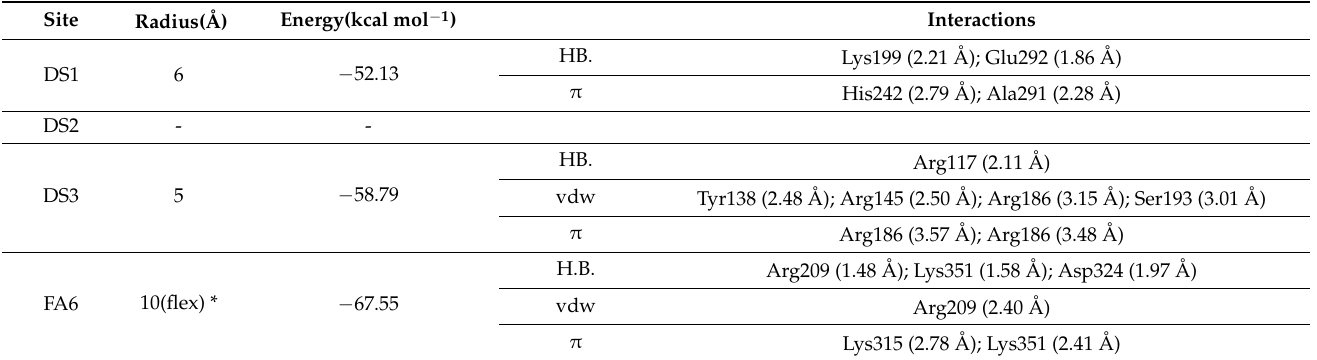
Table 2. Molecular docking results for PDBs, 2BX8, and